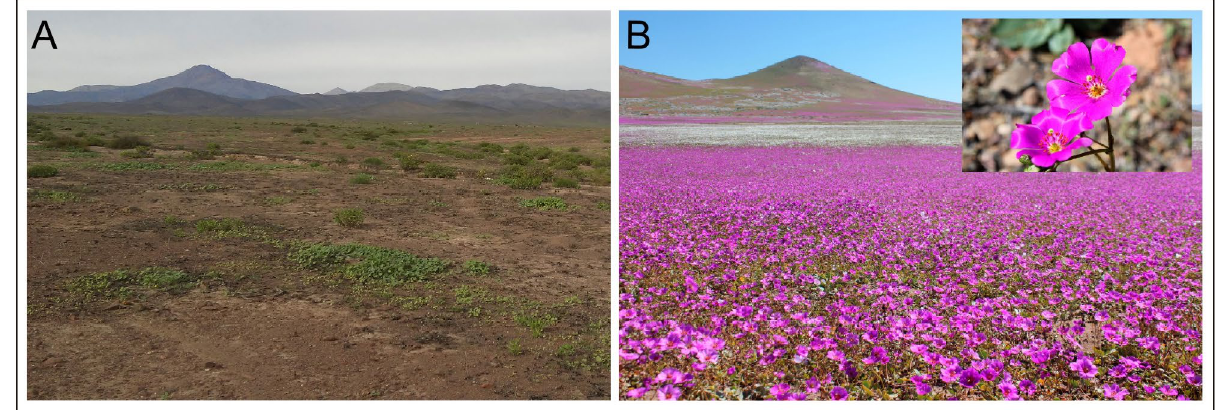
Figure 1. Mantles of Cistanthe longiscapa during preflowering ( A ) and full-flowering ( B ) stages at the 2017 flowering desert event in the Atacama